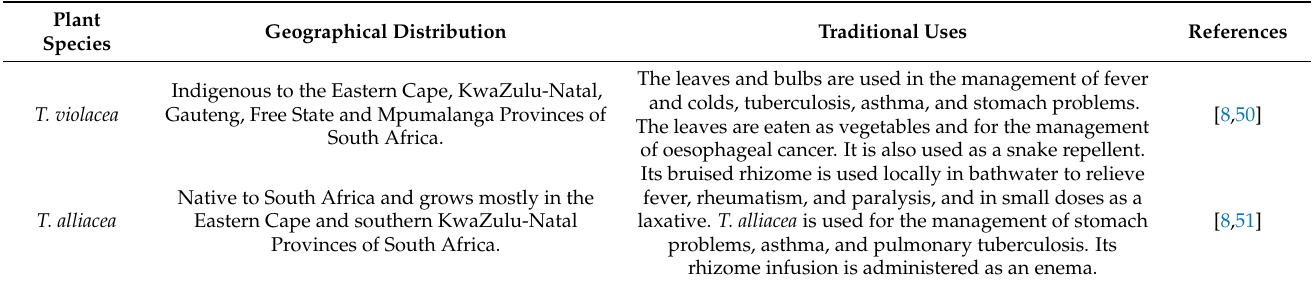
Table 1. Geographical distribution and traditional uses of Tulbaghia